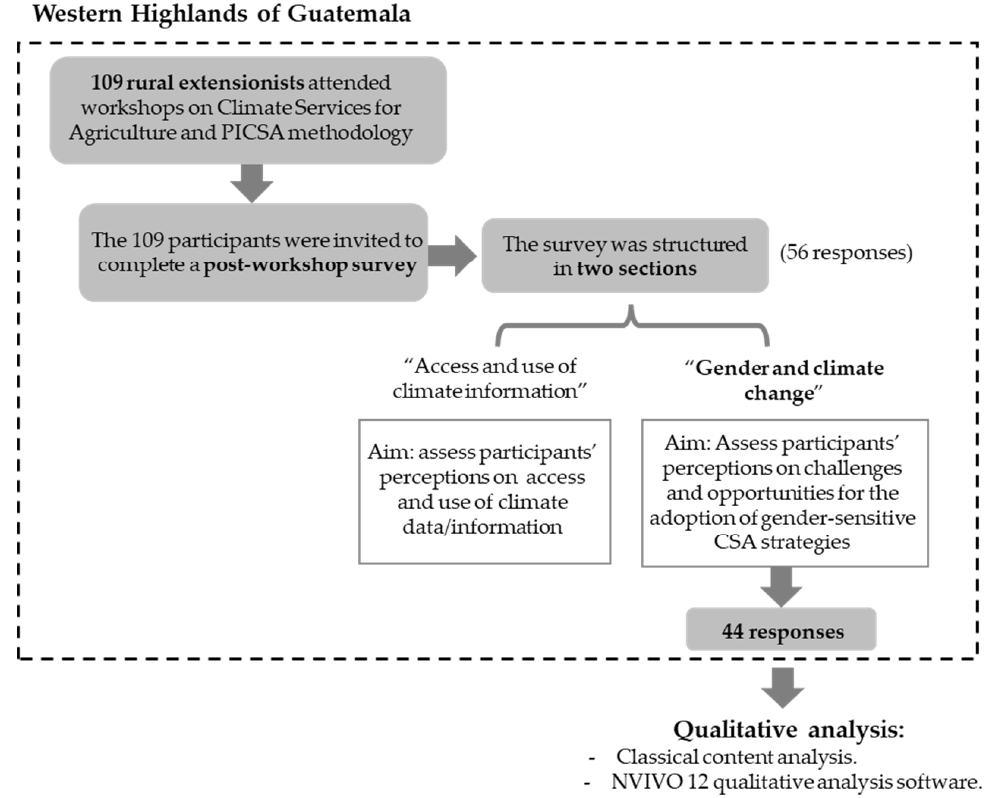
Figure 3. Summary of the methodological approach.